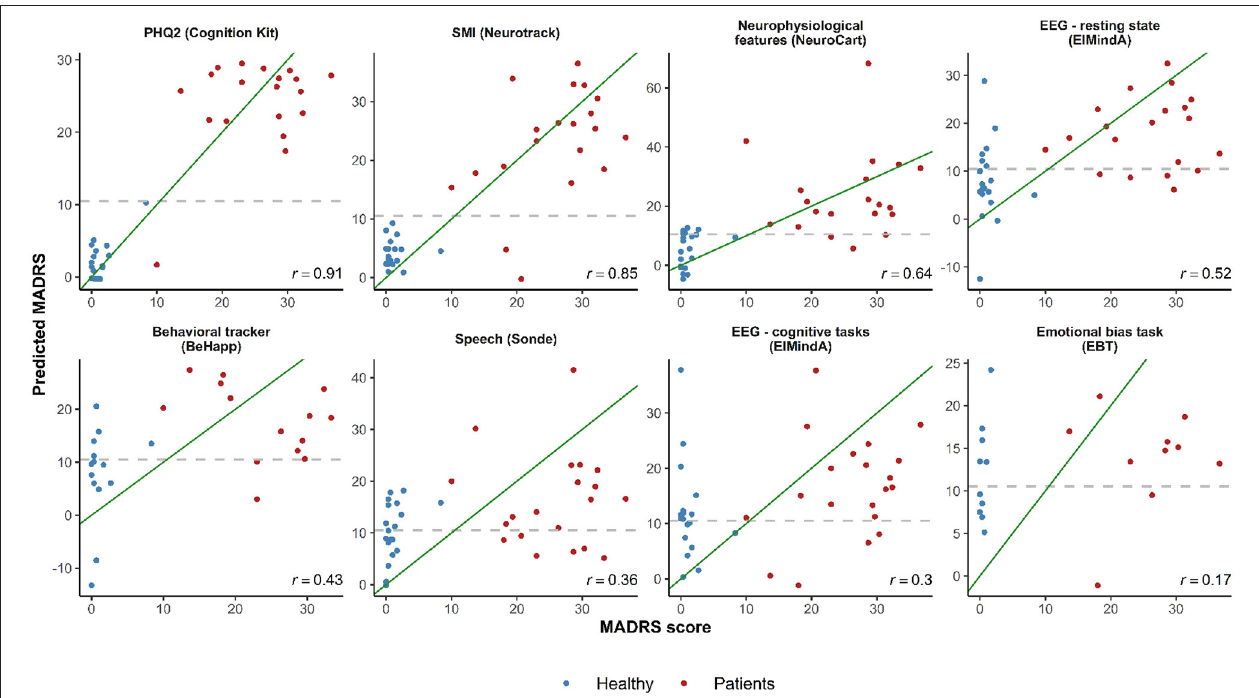
FIGURE 3 | Observed vs. predicted average total MADRS score using different digital technology features. The green diagonal line represents a perfect match between observed and predicted MADRS total scores. In case of a strong linear relationship between MADRS total score and selected features, the observations are expected to fall along the green diagonal line. The gray dashed horizontal line at 10.5 represents a classification threshold: when predicted MADRS total scores for healthy subjects are above 10.5 or similar values for depressed subjects are below 10.5, these observations would be misclassified based on the linear model classifier. PHQ2 is a self-reported score of mood assessment. SMI is a subjective memory impairment